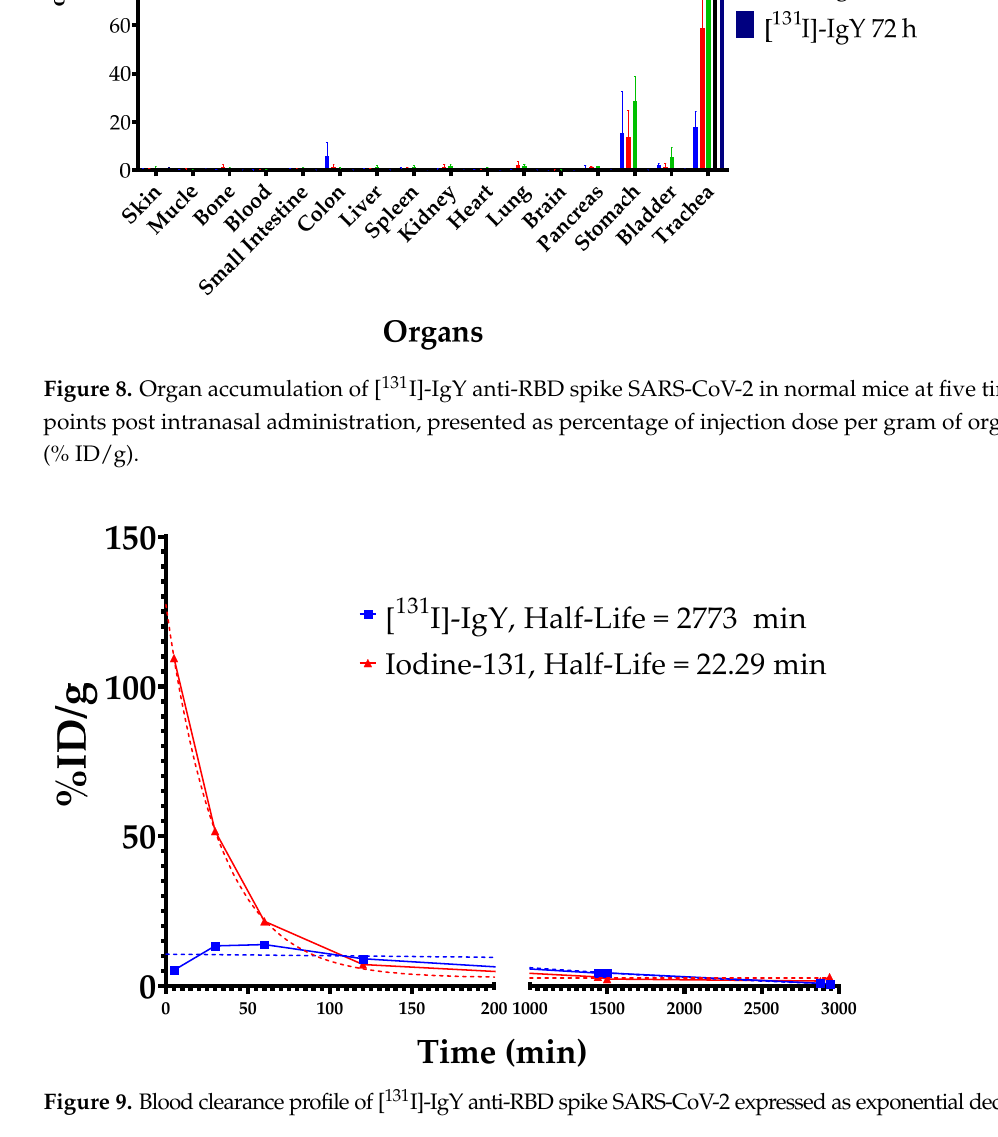
Figure 9. Blood clearance profile of [ 131 I]-IgY anti-RBD spike SARS-CoV-2 expressed as exponential decay.